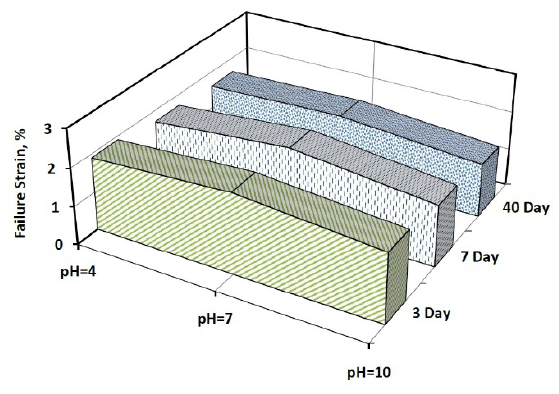
Figure 10: Failure strain of 5% cement-stabilized samples in various environments in terms of acidity.